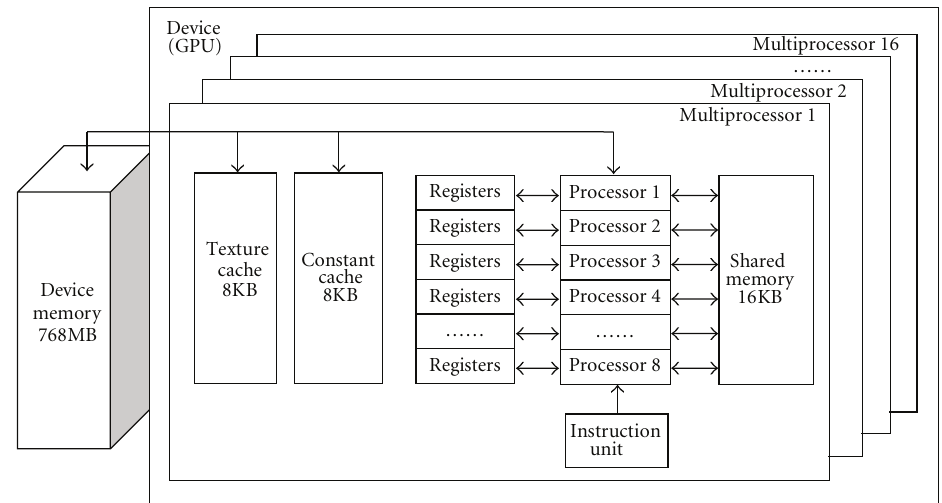
Figure 4: Architecture of NVIDIA’s GeForce 8800